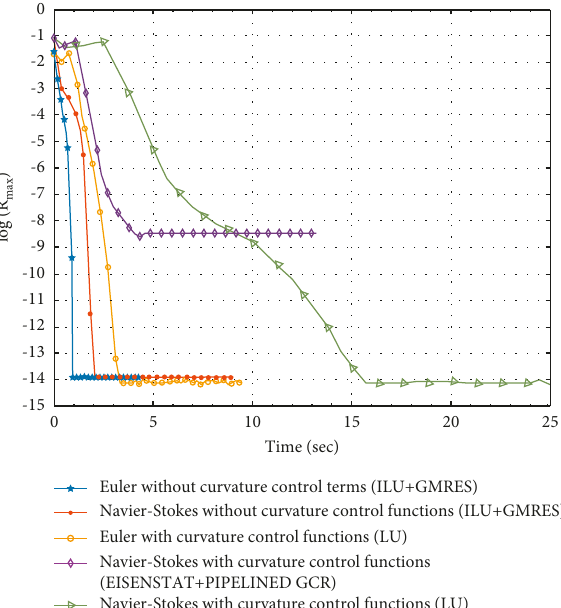
Figure 18: Convergence of the Navier–Stokes mesh vs. time, with curvature